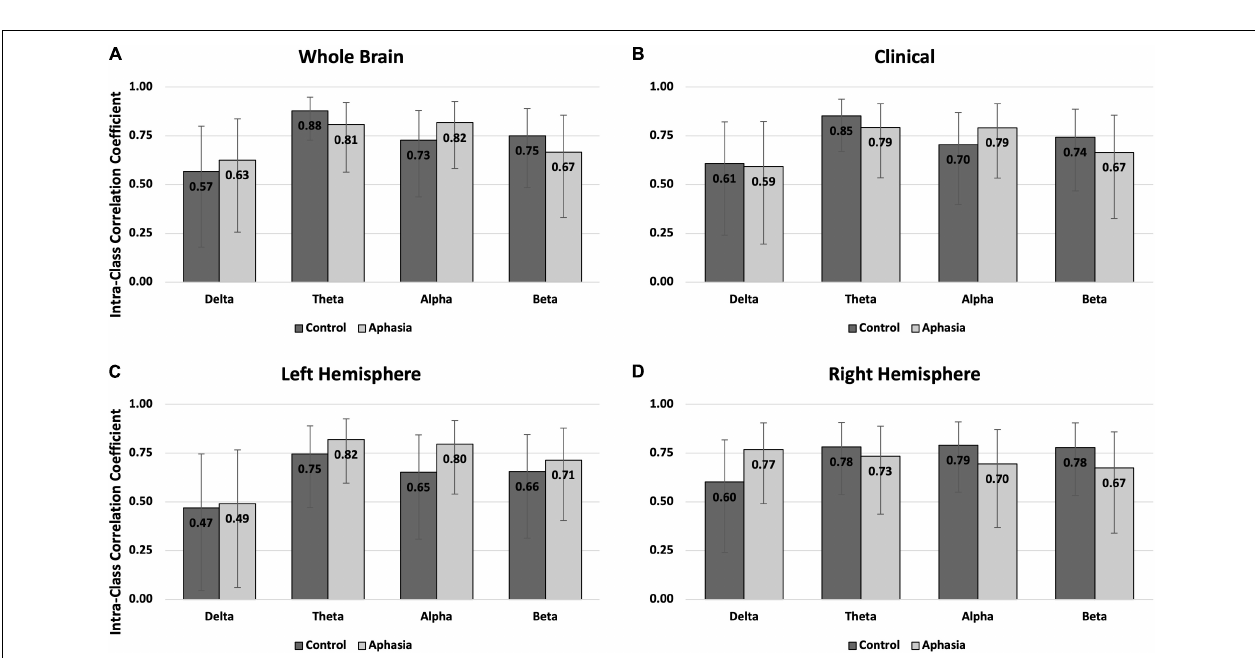
FIGURE 3 | Intra-class correlations by group and frequency band for the eyes closed rest condition in (A) the whole brain montage; (B) the clinical montage; (C) the left hemisphere montage; and (D) the right hemisphere montage. Error bars represent the 95% confidence interval of the point estimates reported in Table 3 .